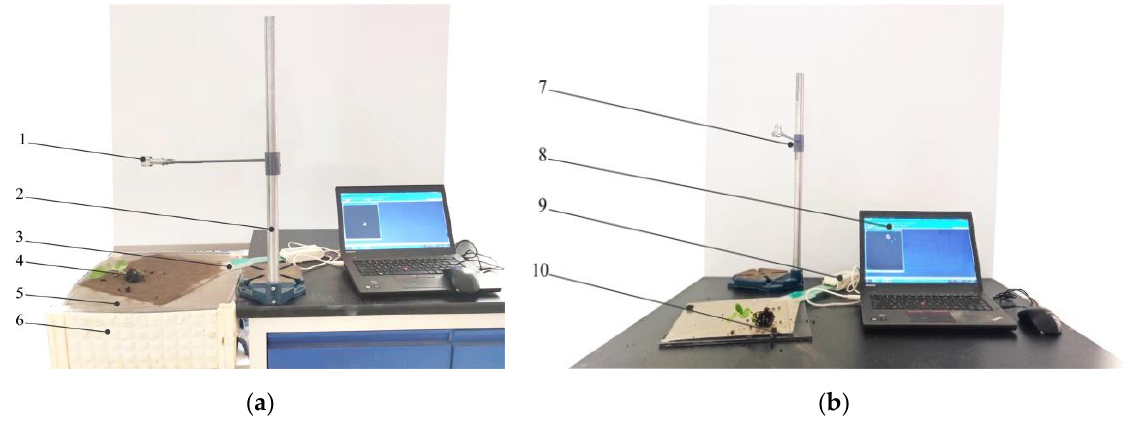
Figure 3. Drop impact test on oil sunflower plug seedlings. ( a ) Drop impact test between oil sunflower plug seedlings and the soil; ( b ) drop impact test between oil sunflower plug seedlings and steel plate. 1. Seedling gripper; 2. Frame; 3. 5250 flexible thin-film-network tactile pressure sensor; 4. Plug seedlings; 5. Plastic film; 6. Test soil bin; 7. Fastening bolts; 8. Computer and I-Scan System data processing system; 9. Handles; 10.The steel plate.